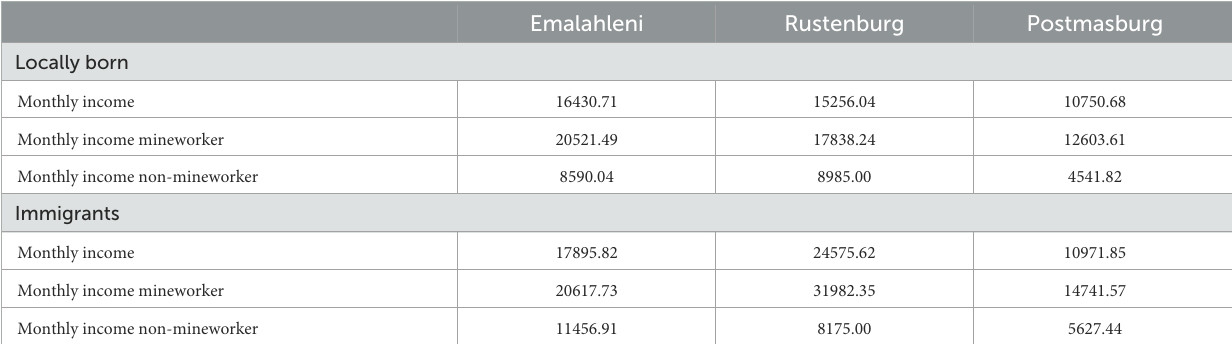
TABLE 2 Average income for different categories of